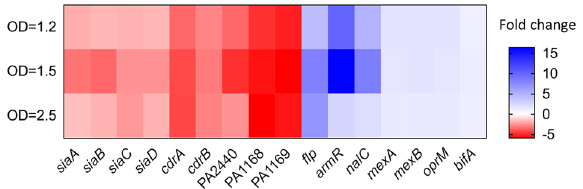
Fig. 10 Heat-map showing the expression level of selected genes determined by RNA-seq analysis of H6-335-P1-treated P. aerugi- nosa Δ wspF Δ pel Δ psl compared with untreated control. The results are based on three biological experiments ( n = 3). OD: Cell densities measured as OD 600